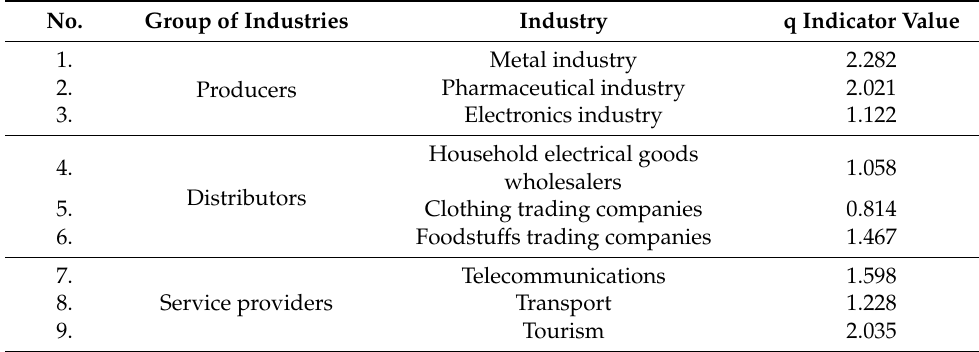
Table 7. The value of q i parameter for individual industries.